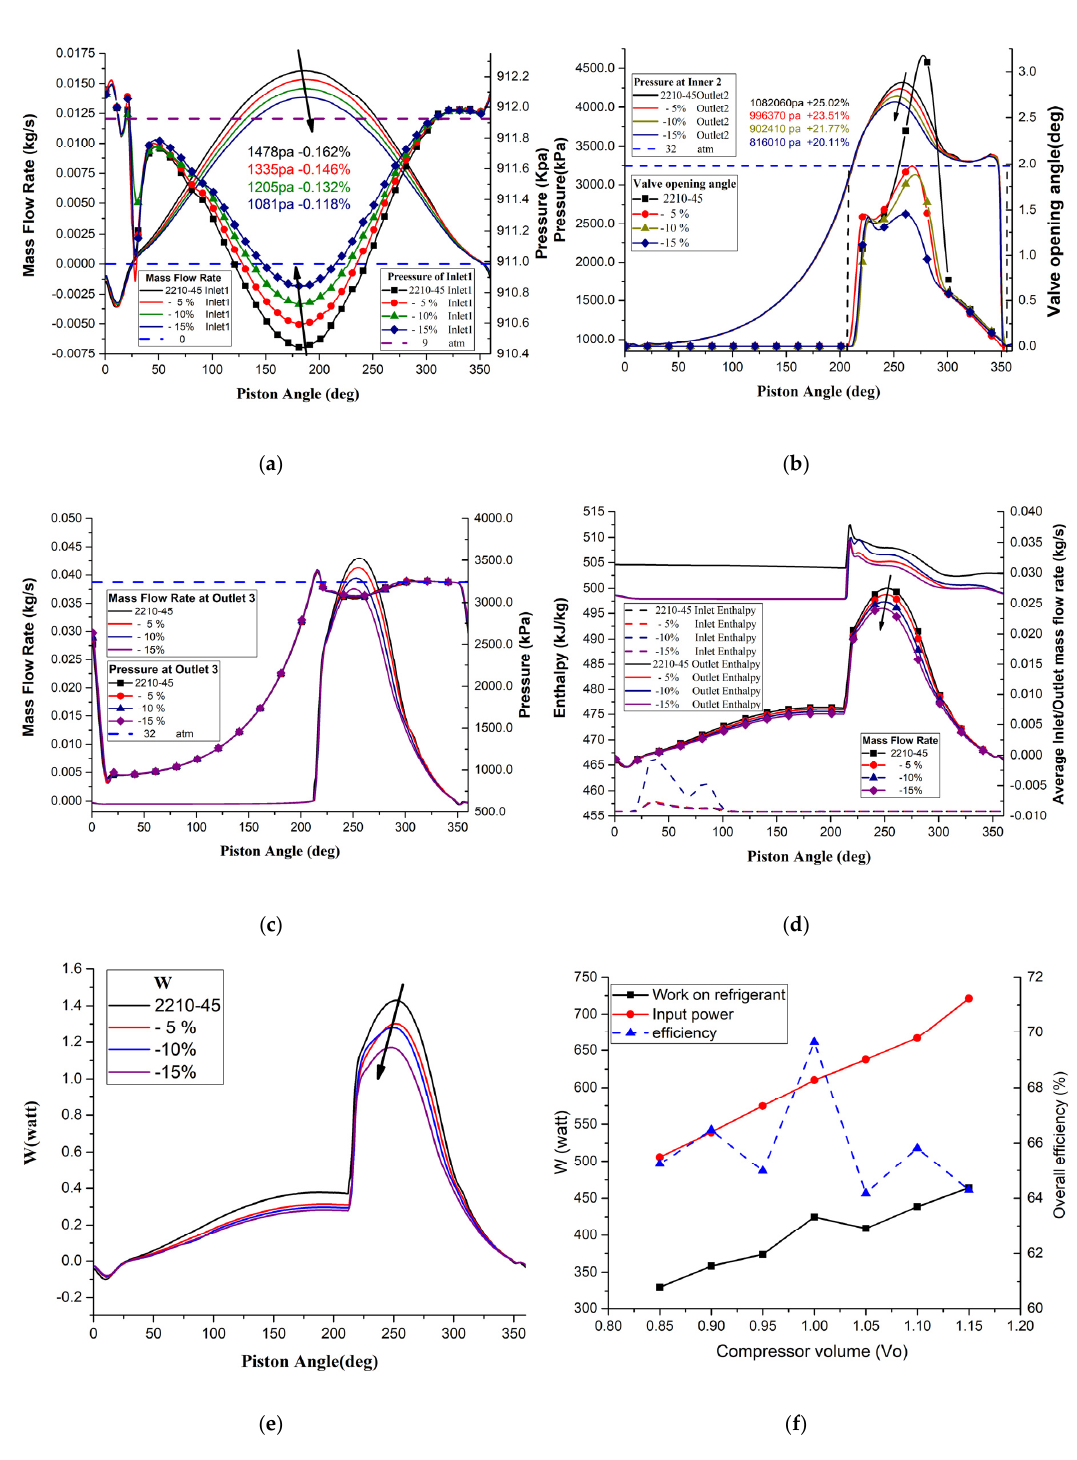
Figure 13. Physical properties of di ff erent volumes by decreasing original one up to − 15% in 5% decrement: ( a ) mass flow rate and pressure at Inlet 1; ( b ) pressure of compression chamber at Inner 2 and opening angle of reed valve; ( c ) discharge mass flow rate and pressure at Outlet 3; ( d ) enthalpy at inlet / outlet and average mass flow rate, ( e ) instantaneous rate of work done on the refrigerant, ( f ) mean work done on the refrigerant, input power and overall e ffi ciency, Vo is the volume of original type, 2210-454.4. Inlet Angle Effect